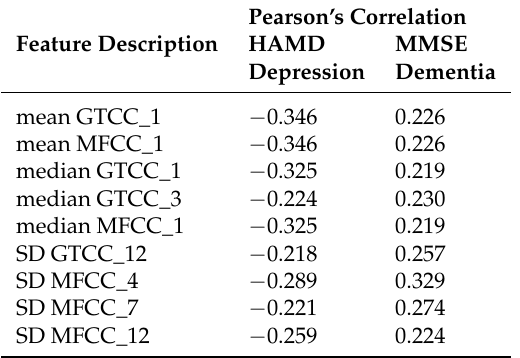
Table 4. Features with significant Pearson correlation in both depression and dementia patients.